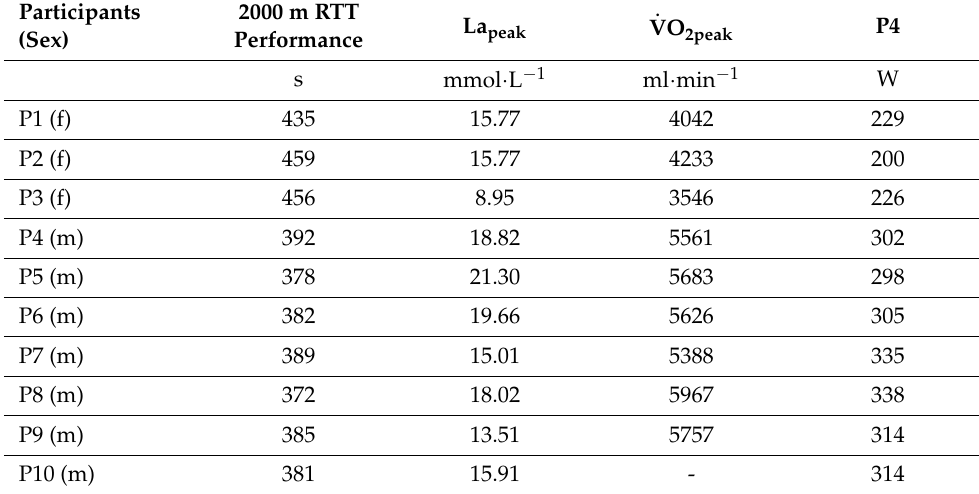
Table 2. Physiological variables obtained during and after 2000 m RTT and power output (W) at 4 mmol · L − 1 determined during the incremental step